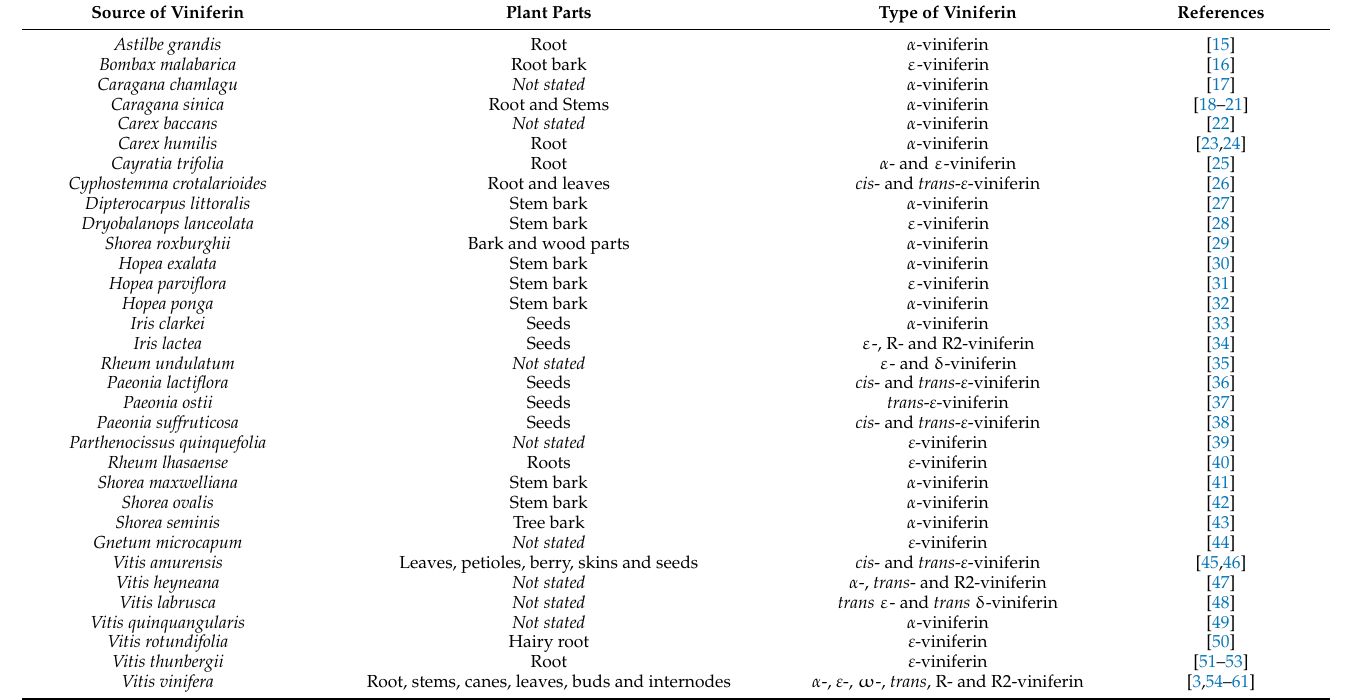
Table 1. Source and distribution of